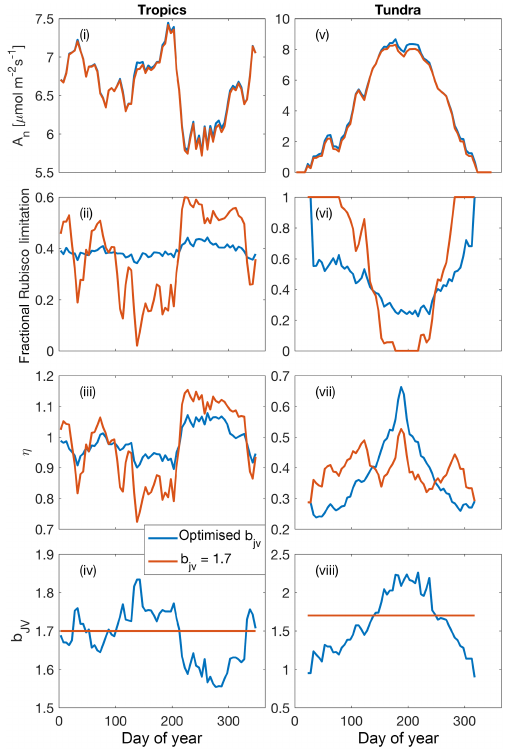
Figure 8. Illustrative simulations of net photosynthesis, fractional Rubisco limitation, elasticity of net photosynthesis with respect to surface (CO 2 ) and b JV = J max,0 /V cmax,0 for shaded leaves in a tropical forest environment (2.25 ◦ S, 63.2 ◦ E) (i) – (iv) and a tundra environment (61.75 ◦ N, 75.75 ◦ W) (v) – (viii) aggregated over 5-day periods. Simulations were performed under assumptions of dynam- ically optimised and fixed b JV for a 365-day period (1990 meteo- rology, 400ppm CO 2